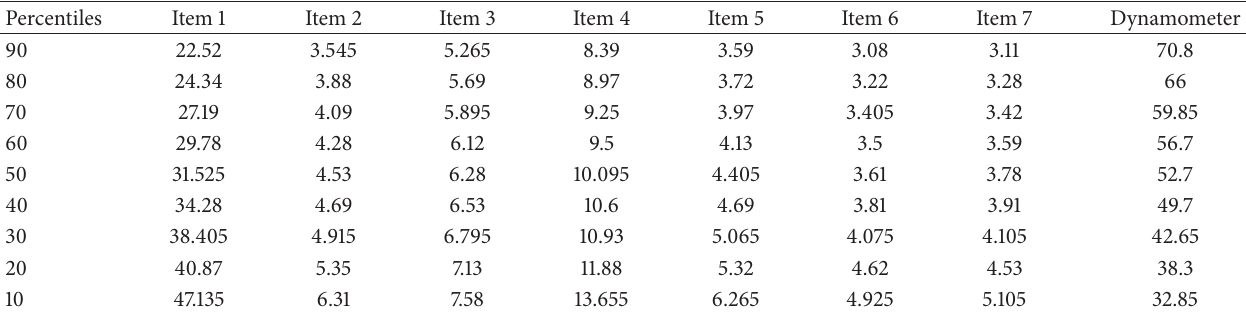
Table 11: 𝑛 = 74 , females, 20–94, nondominant hand, educational instruction: secondary school.